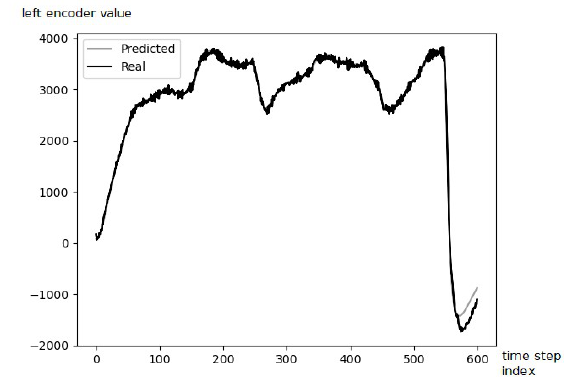
Fig. 5. An example of the left encoder readings – forecasted (grey) and real (black) values applying the stacked LSTM model. In these figures, it can be seen that the forecasted gyroscope readings have higher error throughout the time series and especially at the peaks, in comparison with the forecasts of the encoder data. An important difference is also the noise that is noticeable in the actual value and is missing in the forecasts.